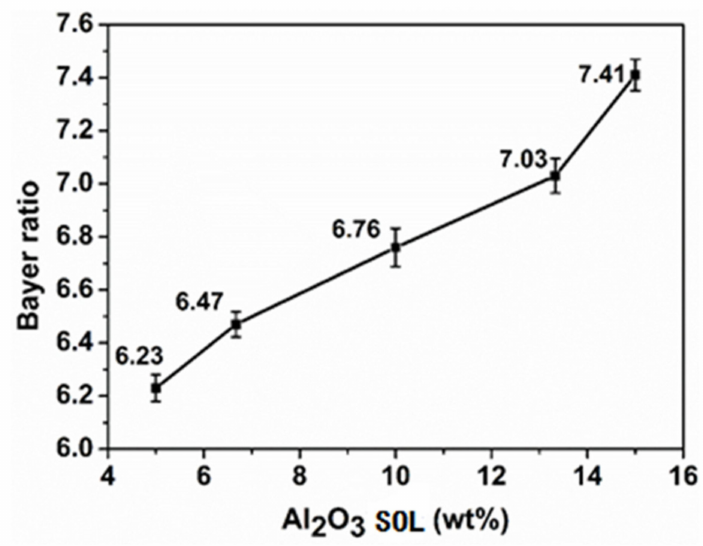
Figure 11. Variation of Bayer ratio of composite coatings with di ff erent Al 2 O 3 sol